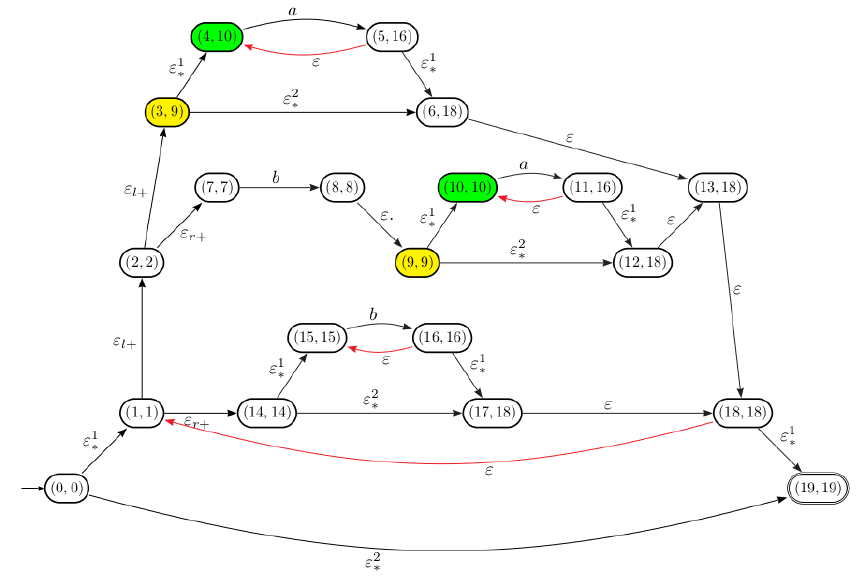
Figure 6. The automaton Id ( T E ) associated with E = ( a ∗ + ba ∗ + b ∗ ) ∗